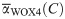
Effect of mutations on CARENET activity.A-E, Simulating effect of hormones on α¯WOX4(C) in pxy, ahk, erf, ipt, and wrky mutant backgrounds. α¯WOX4(C) was averaged for all the simulations with the corresponding control node on (dark green bar) or off (pale green bar). F, Proliferation in pxy, ahk, erf, ipt, and wrky mutant backgrounds.